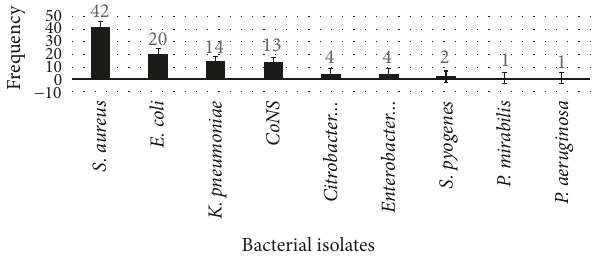
Figure 1: Profile and frequency of bacterial isolates from women having SSI during postnatal period at the University of Gondar Teaching Hospital from 1 January 2016 to 30 May